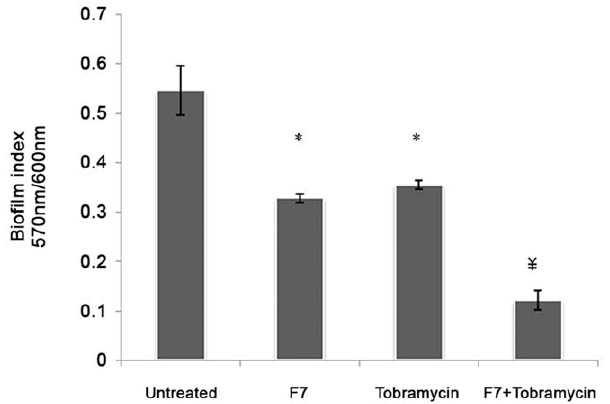
Figure 3. Effect of F7 (1 mg/ml) and tobramycin (20 m g/ml) on biofilm formation by P.aeruginosa PAO1.